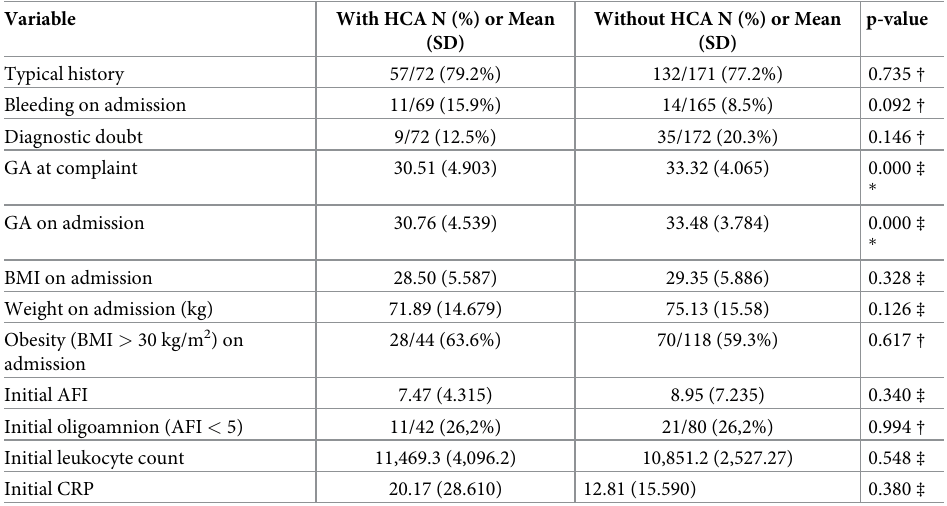
Table 1. Initial clinical condition of 295 pregnant women with PPROM according to the presence or absence of HCA.